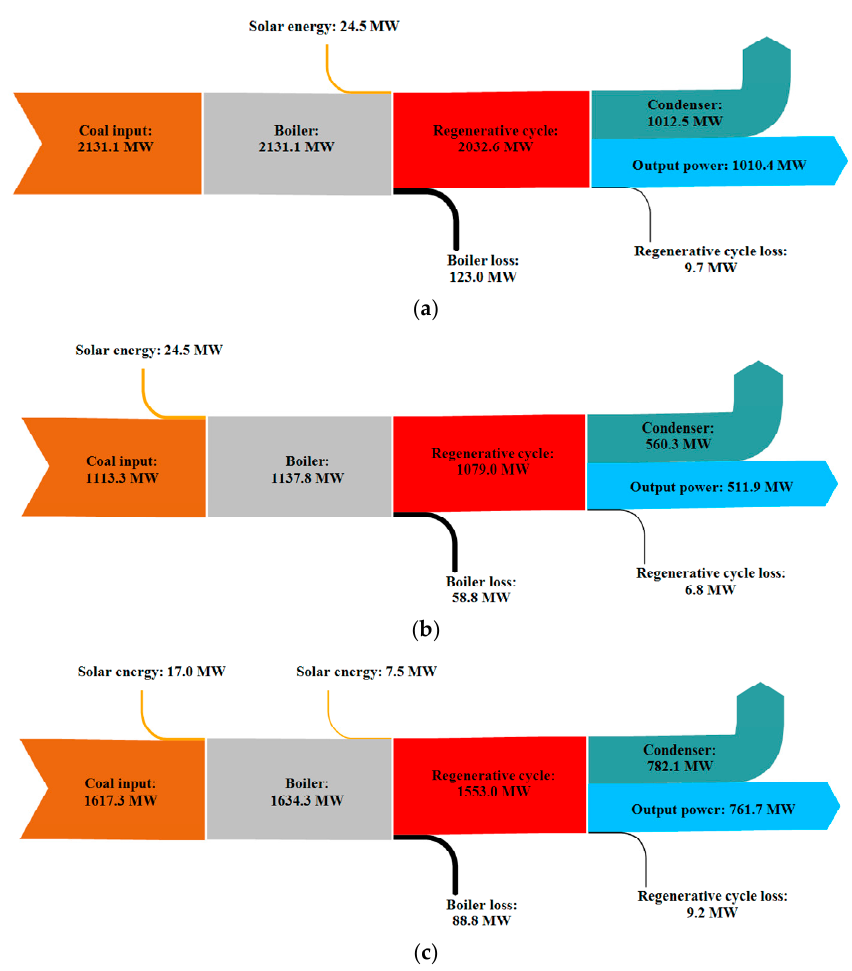
Figure 7. Energy flow of the proposed SAPG. ( a ) High load; ( b ) low load; ( c ) medium load.